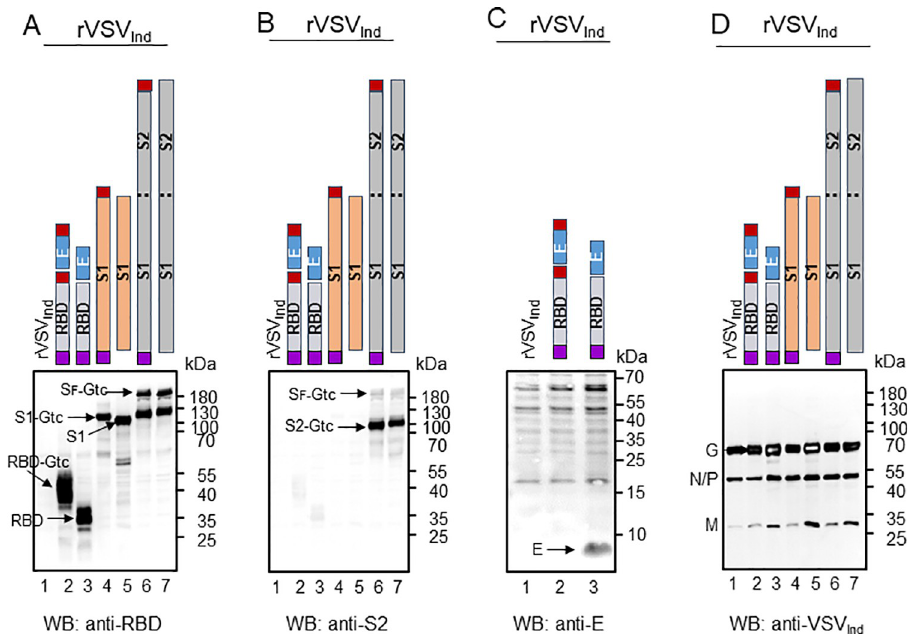
Fig 2. Expression of SARS-CoV-2 proteins from rVSV Ind -SARS-CoV-2. To check the expression of SARS-CoV-2 RBD, S1, S F , and E proteins from the rVSV Ind -SARS-CoV-2 infected cells, BHK-21 cells were infected with the virus at an MOI of 6. After six hours incubation at 37˚C, cell lysates were prepared and protein expression was determined by Western blot analysis. Cell lysates were loaded in 5 μ g quantity for SDS-PAGE. RBD, S1, and S F proteins were detected by rabbit antibody against SARS-CoV-2 RBD. S2 protein was detected by rabbit antibody against SARS-CoV-2 S2. E protein was detected by rabbit antibody against SARS-CoV-2 E peptides. (A) Expression of RBD, S1, and S F with and without msp and Gtc. (B) Expression of S2 with and without Gtc. (C) Expression of E protein. (D) Expression of VSV Ind N, P, M, and G proteins. Purple box: honeybee msp, red box: VSV Gtc.